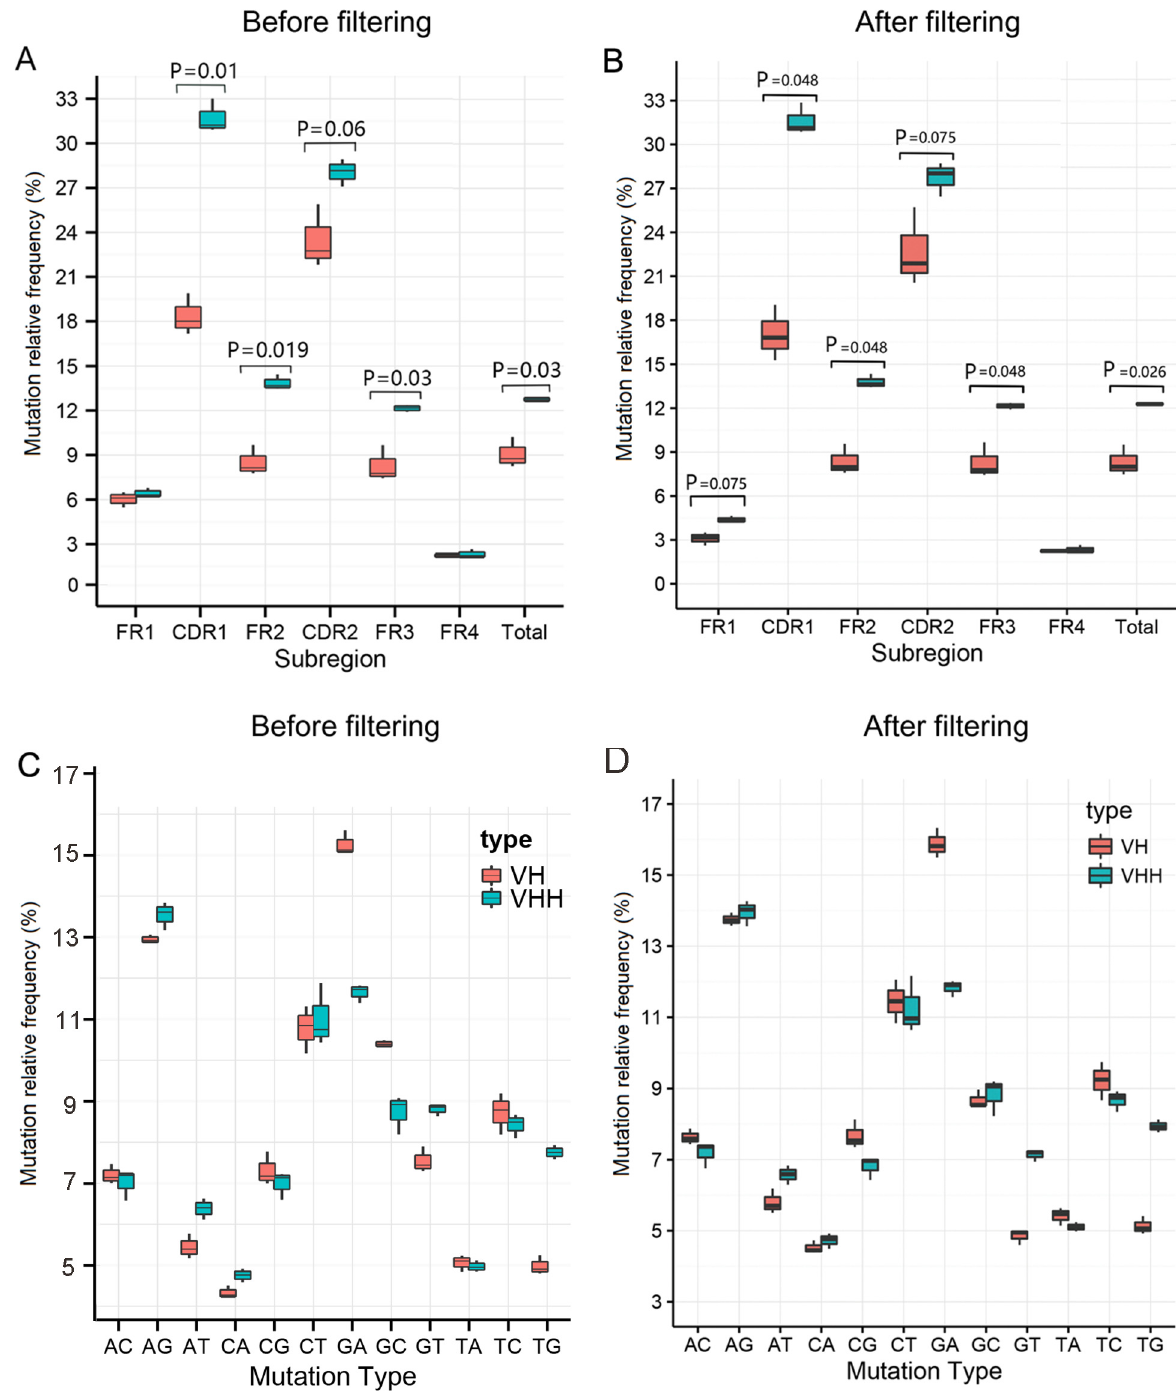
Fig 3. Box plots of the mutation rate analysis. a The mutation rates of each sub-region including FR1, CDR1, FR2, CDR2, FR3, and FR4 in three samples before filtering. Mutations are defined as mismatches with the IMGT references on each sample ’ s sequences. b The mutation rates of each sub-region including FR1, CDR1, FR2, CDR2, FR3, and FR4 in three samples after filtering. c Statistics of specific nucleic acid mutations of the VH and VHH clones before filtering. d Statistics of specific nucleic acid mutations of the VH and VHH clones after filtering. Box plot explanation: upper horizontal line of box, 75th percentile; lower horizontal line of box, 25th percentile; horizontal bar within box, the median of the three samples ’ data; upper end of the whisker, maximum of the three samples ’ data; lower end of the whisker, minimum of the three samples ’